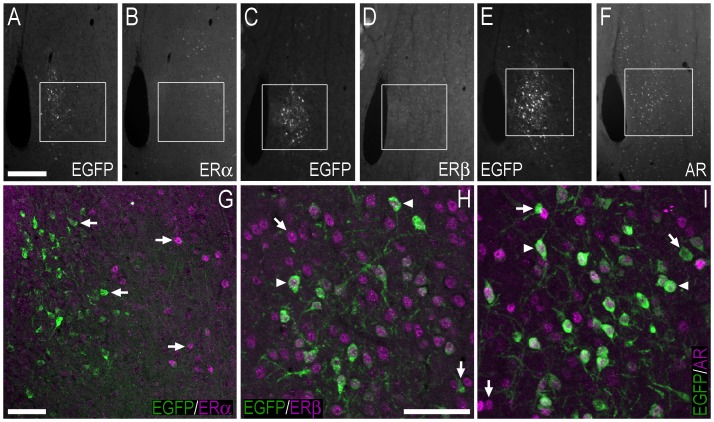
Double-immunofluorescence photo and confocal micrographs showing the distribution of EGFP−, ERα−, ERβ-, and AR-LI in the lateral septal nucleus.(A, B) Single-channel photomicrographs of double-fluorescence immunohistochemistry, showing EGFP− (A) and ERα-LI (B) (Bregma, +0.74 mm). (C, D) Single-channel photomicrographs of double-fluorescence immunohistochemistry, showing EGFP− (C) and ERβ-LI (D) (Bregma, +0.62 mm). (E, F) Single-channel photomicrographs of double-fluorescence immunohistochemistry, showing EGFP− (E) and AR-LI (F) (Bregma, +0.62 mm). (G–I) Confocal micrographs of double-immunofluorescence histochemistry displaying (G) EGFP− (green) and ERα-LI (magenta), (H) EGFP− (green), and ERβ-LI (magenta), and (I) EGFP− (green) and AR-LI (magenta). Confocal micrographs in (G), (H) and (I) are magnified views of the white squares shown in (A, B), (C, D) and (E, F), respectively. In G–I, arrows point to single labelled cell bodies, and arrowheads point to double-labelled cell bodies. Scale bars: A = 200 µm, applies A–F; G = 50 µm; H = 50 µm, applies H, I.